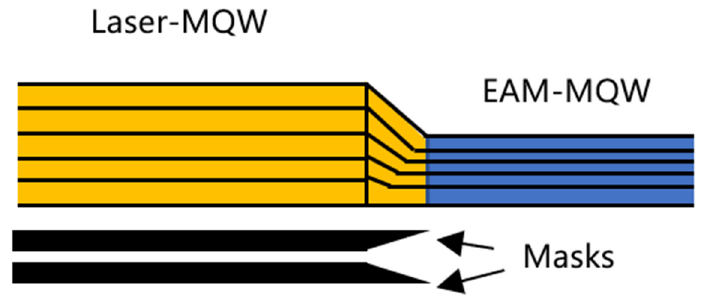
Figure 20. Schematic of the EAM and laser MQWs achieved using the SAE technique. Zhao et al. [82] integrated a high-mesa DFB laser and EAM using SAE. The absorption and active regions consisted of an InGaAsP/InGaAsP MQW structure and an optical confinement layer with different thicknesses caused by the fusiform mask, as shown in Figure 5b. The spacing of the two SiO 2 mask stripes was fixed at 15 µ m, and the mask width varied from 30 to 15 μ m in the tapered region. Figure 21 presents a schematic of this device. The EML CW threshold current was 26 mA without the modulation bias for the uncoated laser. The output power of the modulation was 5.5 mW when the current was 100 mA at the laser, in single–mode operation with a side–mode suppression ratio (SMSR) > 40 dB at 1.552 μ m. The on/off ratio was 15 dB at the biased voltage of − 5 V on the EAM.